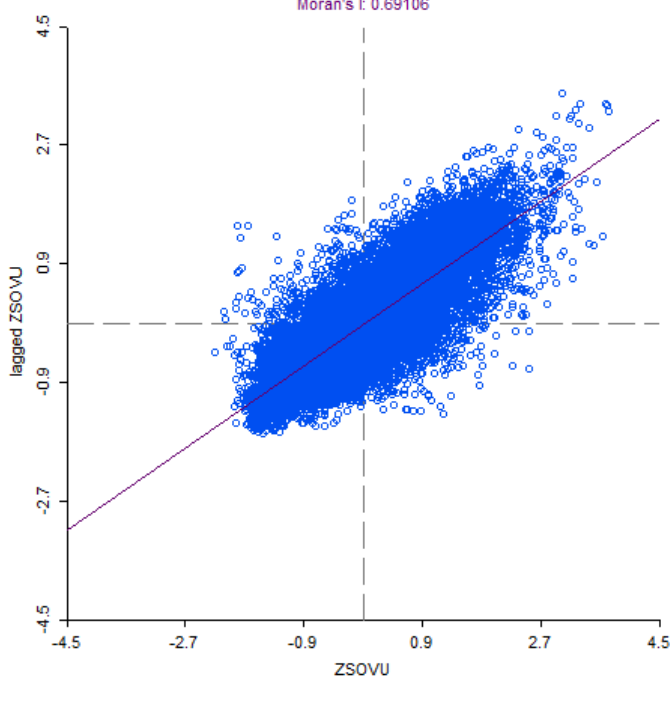
Figure 2. Global Moran’s I for SOVU.